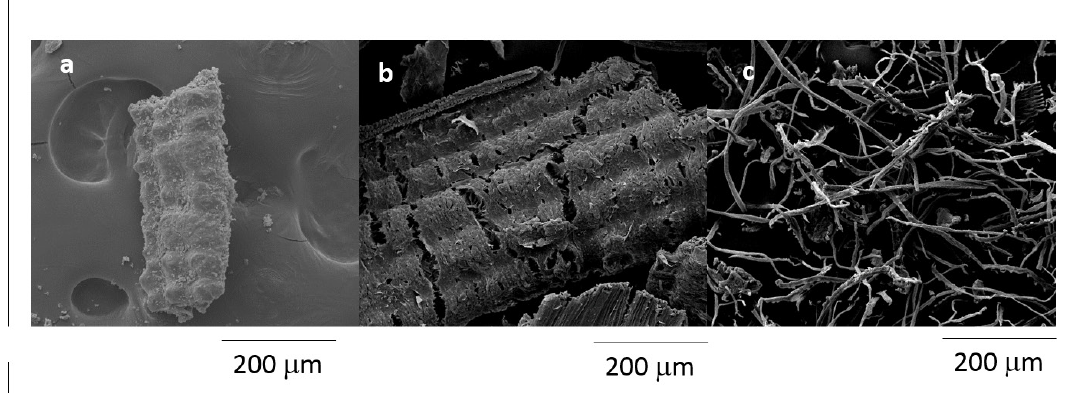
Figure 1. Micrographs obtained using SEM: raw rice hulls (a), rice hulls pre-treated with NaOH (b) and rice hulls treated with NaOH followed by peracetic